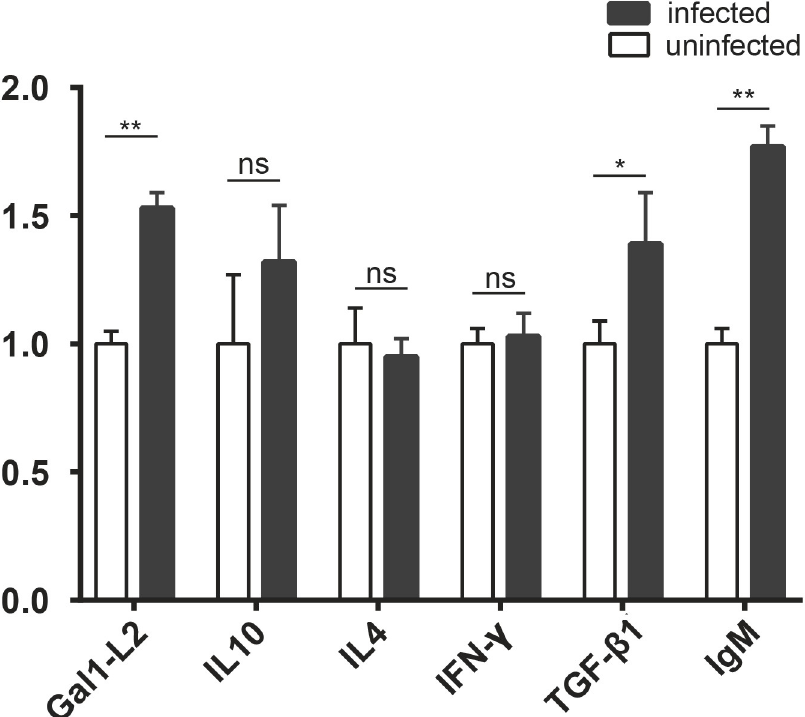
Fig 12. Relative expression of immune-related genes in the intestinal mucosa of grass carp. Uninfected group, without S . acheilognathi infection; infected group, infection with S . acheilognathi ; ns, no significance; “ �� ”, P < 0.01; “ � ”, 0.05 < P <